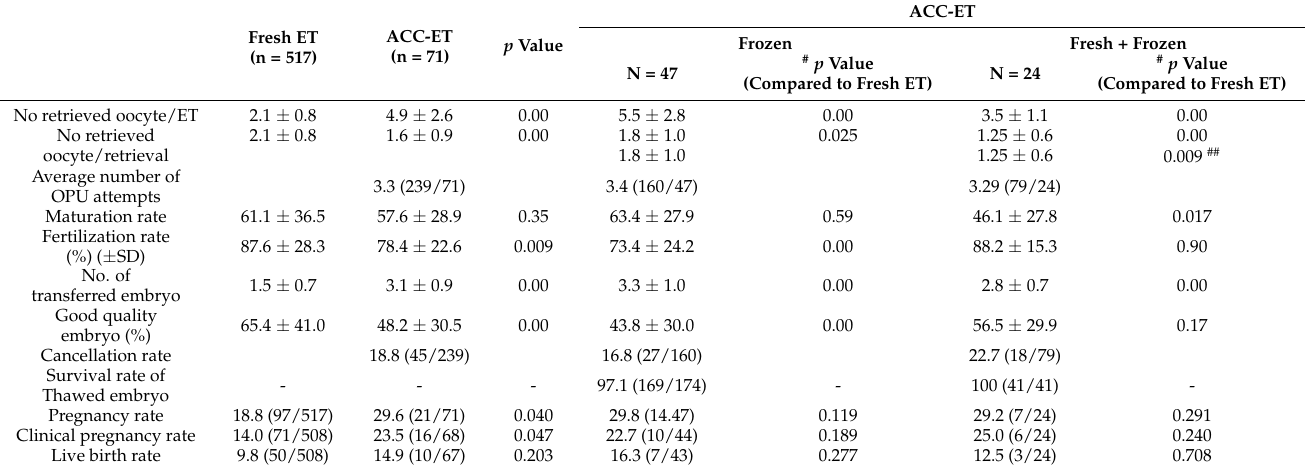
Table 2. Comparison of oocytes and embryologic outcomes between Fresh ET and ACC-ET